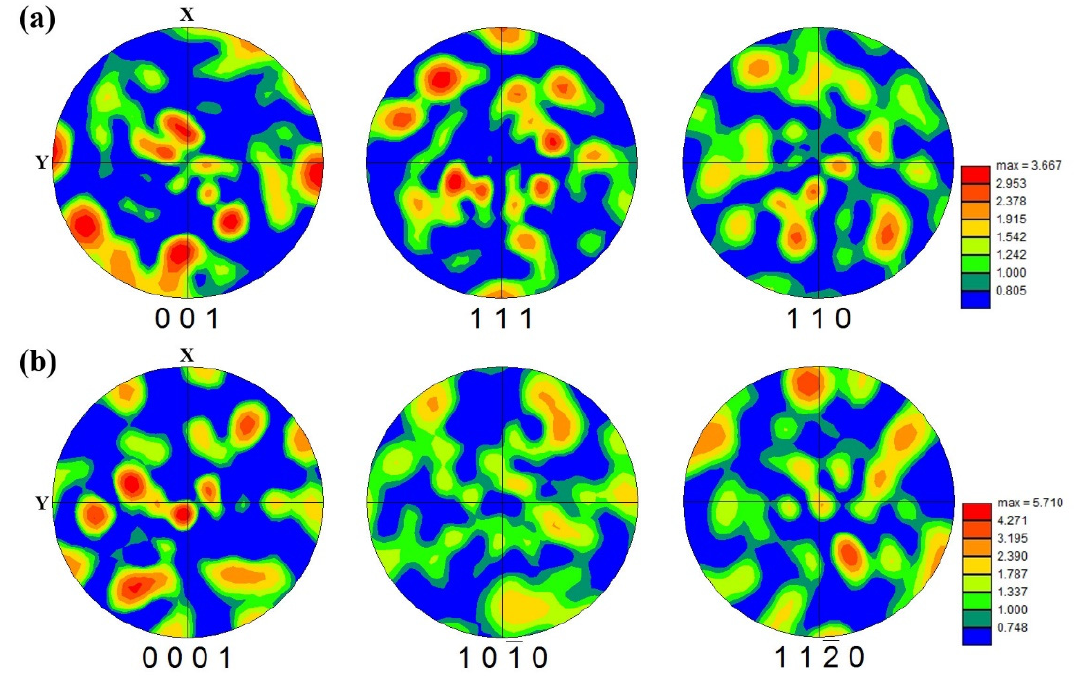
Figure 12. The EBSD pole figure (PF) maps of sample H-X for ( a ) β and ( b ) α phases.